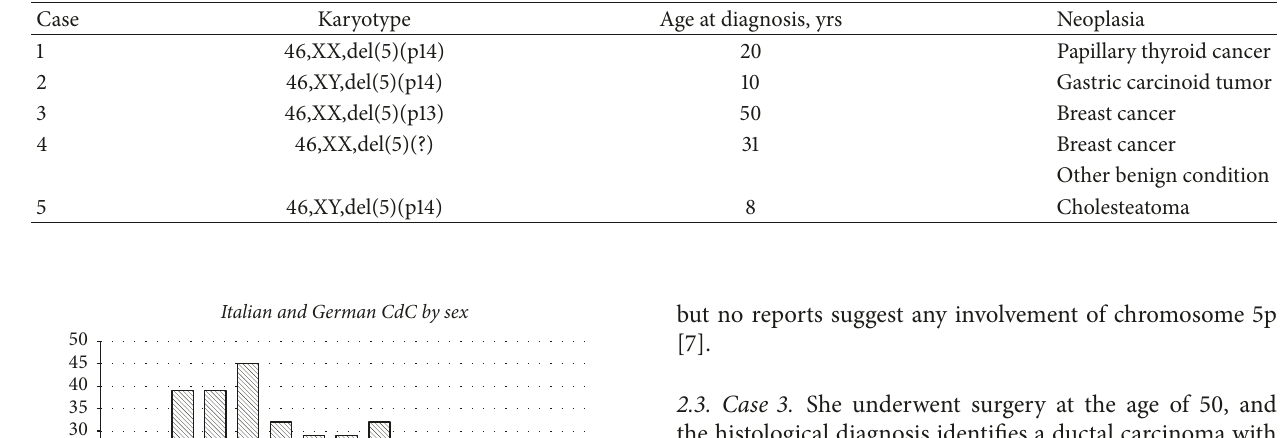
Table 1: List of the five Italian and German CdC patients in whom neoplasia or other benign condition was diagnosed.